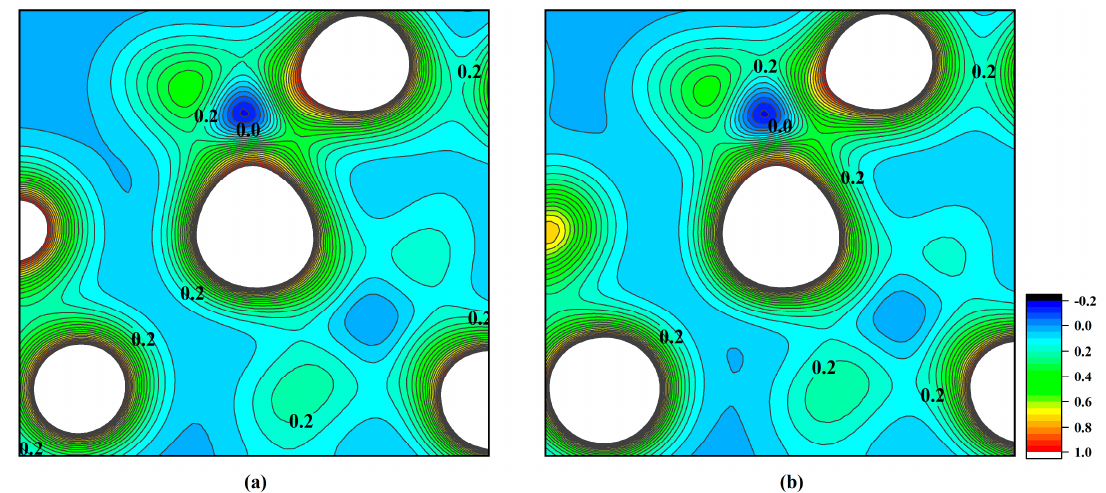
Figure 4. The density of states of the Na-MMT ( a ) and Mg-MMT ( b ) at 0 GPa. Table 5. Bader charges of various atoms of Na-MMT and Mg-MMT.